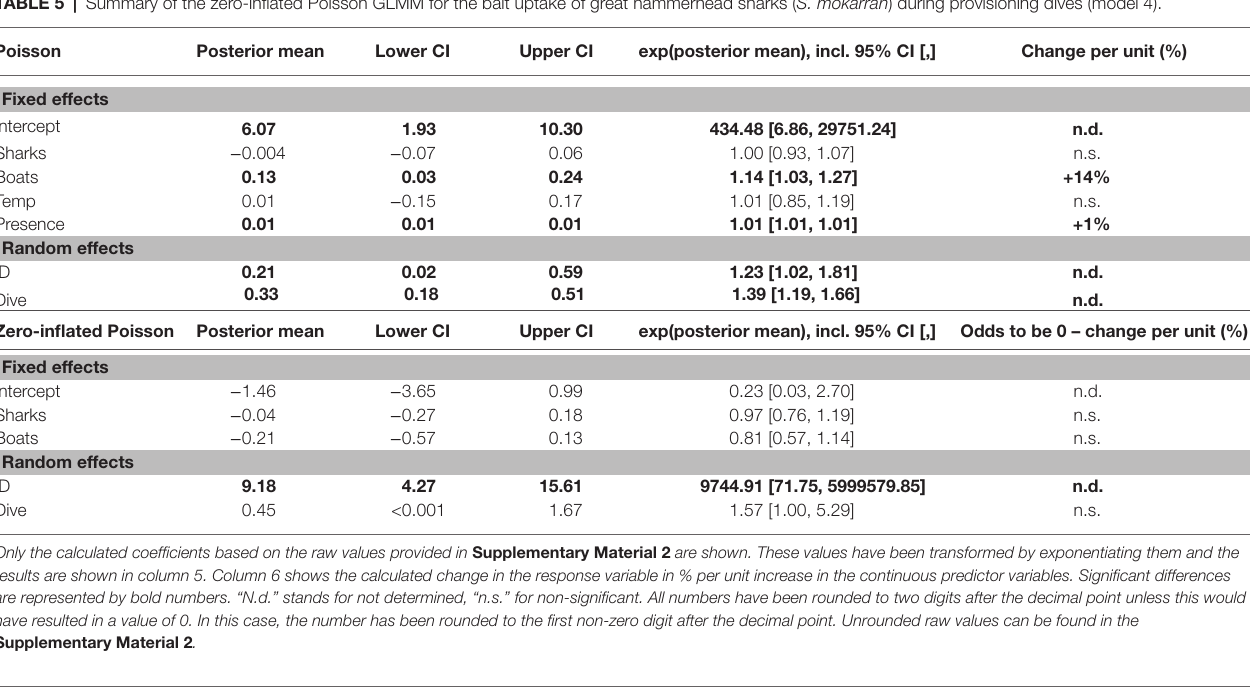
TABLE 5 | Summary of the zero-inflated Poisson GLMM for the bait uptake of great hammerhead sharks ( S. mokarran ) during provisioning dives (model 4).